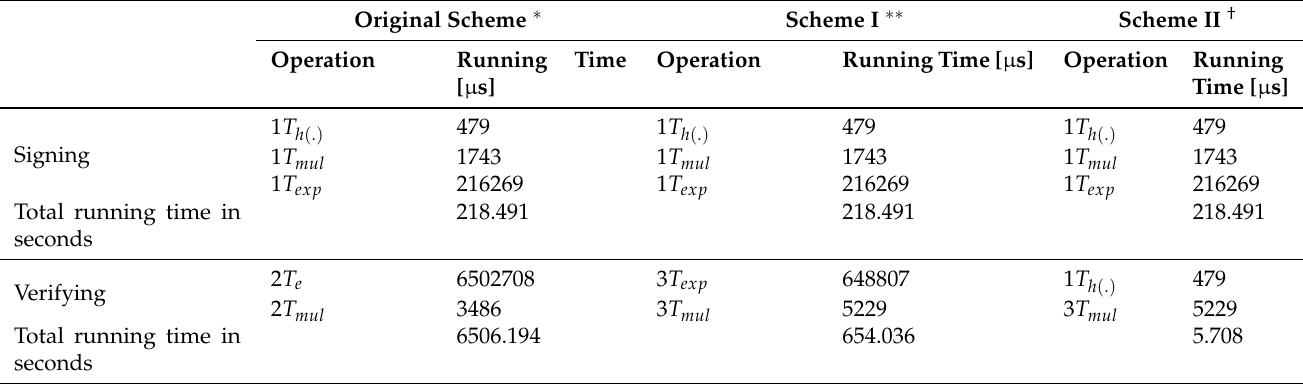
Table 6. Efficiency comparison in embedded device Raspberry Pi 1 Model